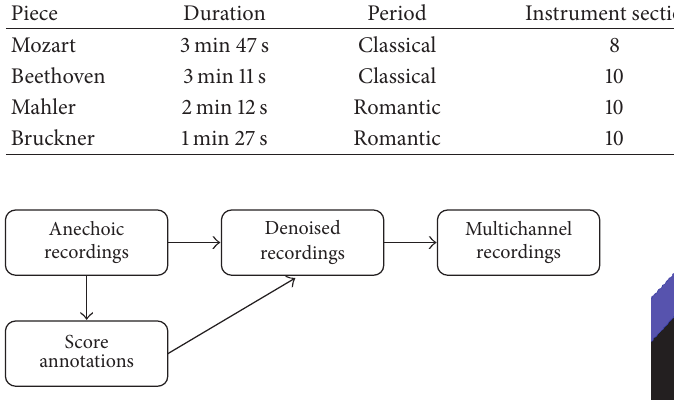
Figure 3: The steps to create the multichannel recordings dataset.